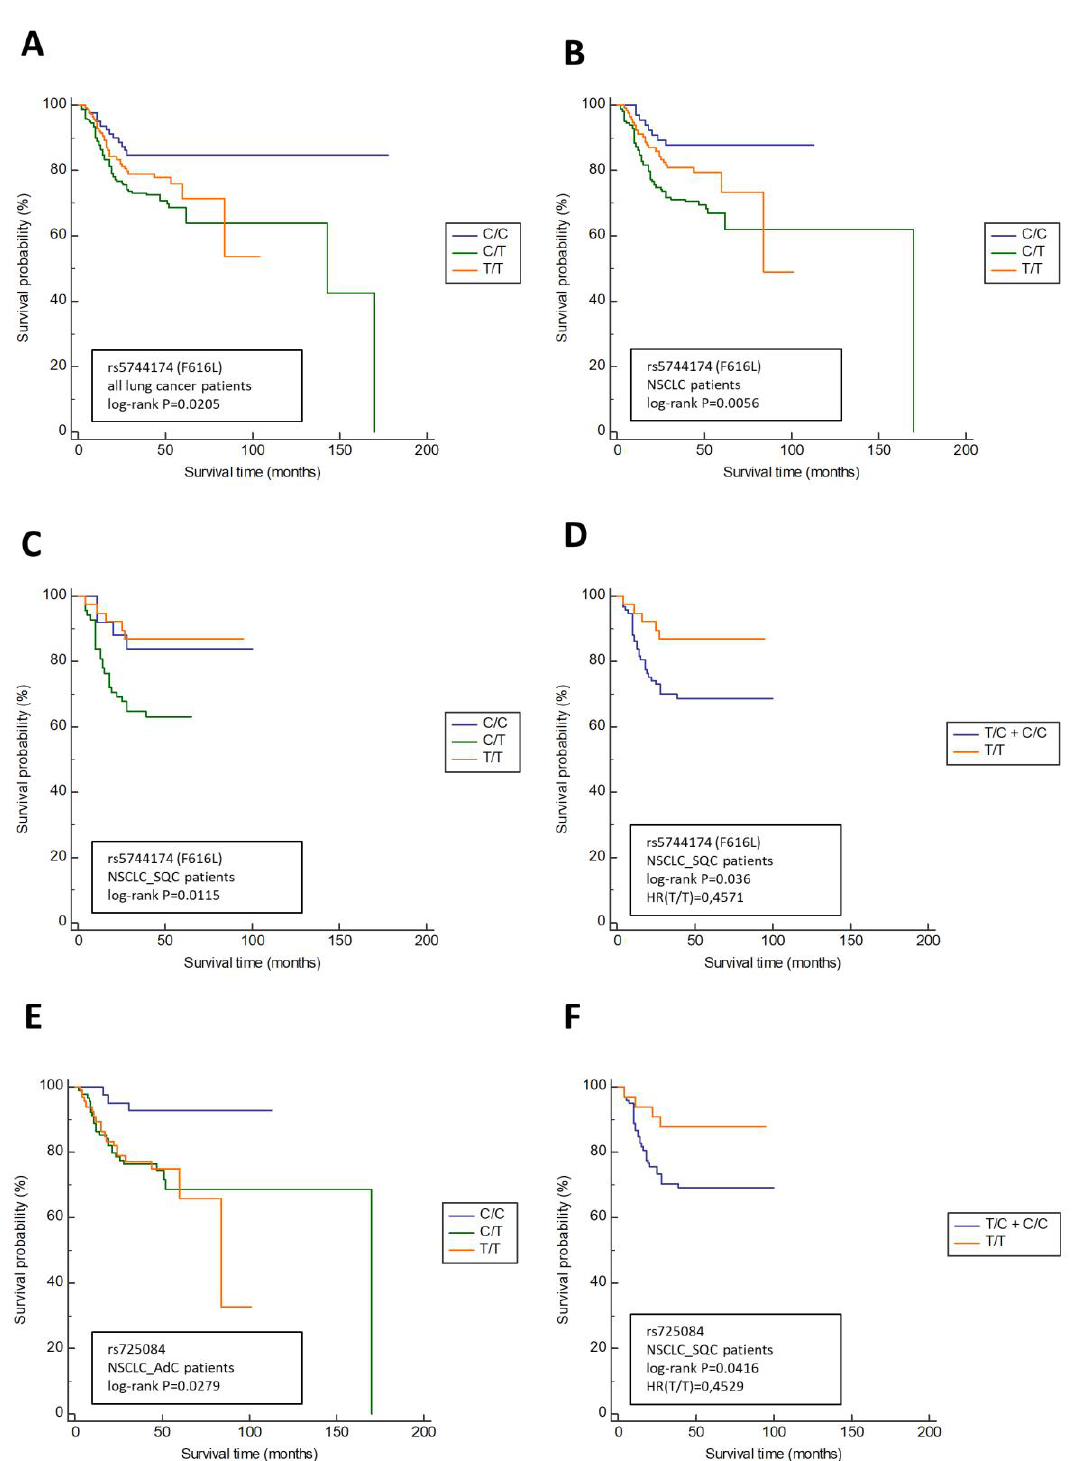
Figure 1 . Kaplan – Meier estimations of lung cancer-specific overall survival according to TLR5 genotypes. ( A ) rs5744174_F616L, all lung cancer patients ( n = 415); ( B ) rs5744174_F616L, only non-small cell lung cancer (NSCLC) patients ( n = 343); ( C ) rs5744174_F616L, only squamous-cell carcinoma (SQC) patients ( n = 131); ( D ) rs5744174_F616L in co-dominant model, only SQC patients ( n = 131); ( E ) rs725084, only adenocarcinomas (AdC) patients ( n = 197); and ( F ) rs725084 in co-dominant model, only SQC patients ( n = 131).